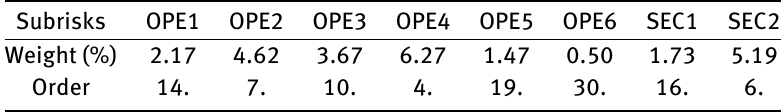
Table 4: Resulting values of subrisks weights – Part II.